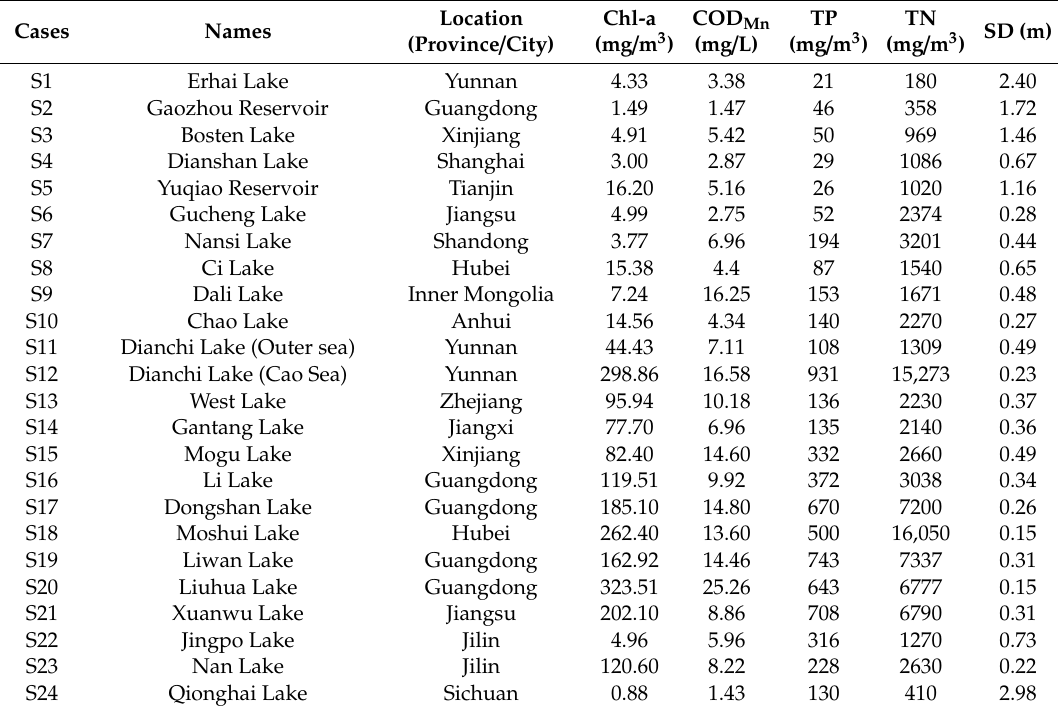
Table 1. Eutrophication data (annual mean values) of 24 typical lakes and reservoirs in